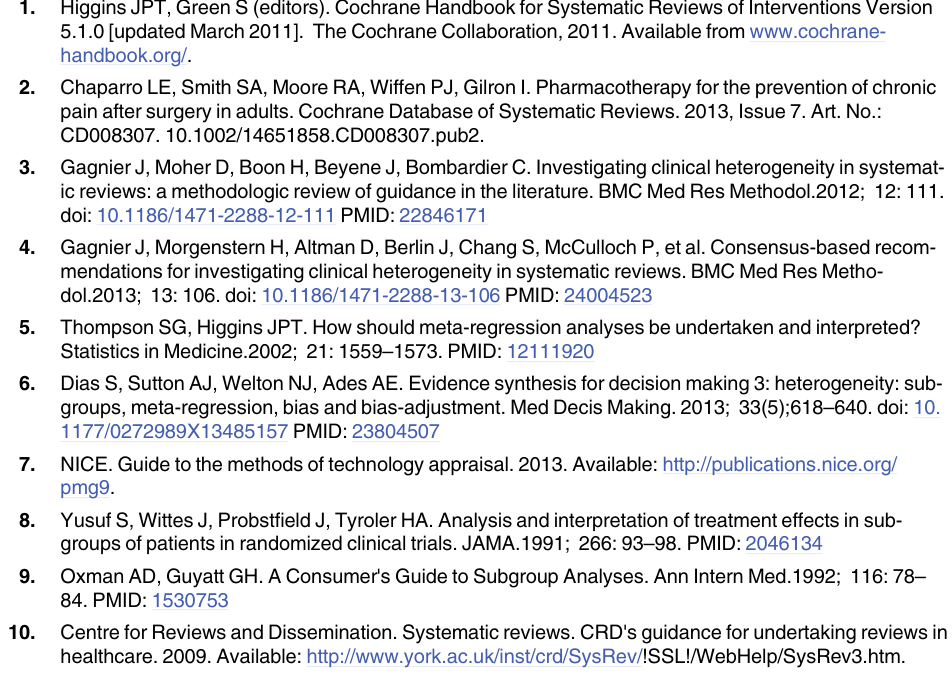
S9 Table. Detecting interactions: planned and used methods to detect interactions. S10 Table. Reporting interaction results: results reported from interaction analysis and from method to detect interactions. S11 Table. Interpreting covariates: Reporting of whether interaction was detected, results from the test for subgroup differences, and discussion of plausibility, confounding and the covariate distribution. S12 Table. Rationale for covariates (when reported). S13 Table. Justification for covariate categories (when